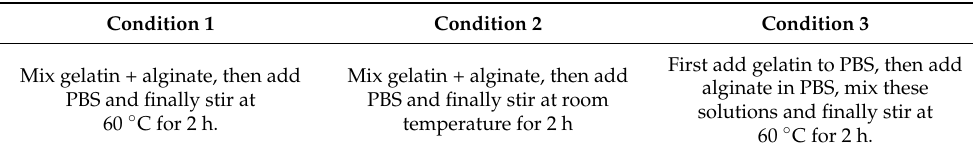
Table 2. Different conditions during ink